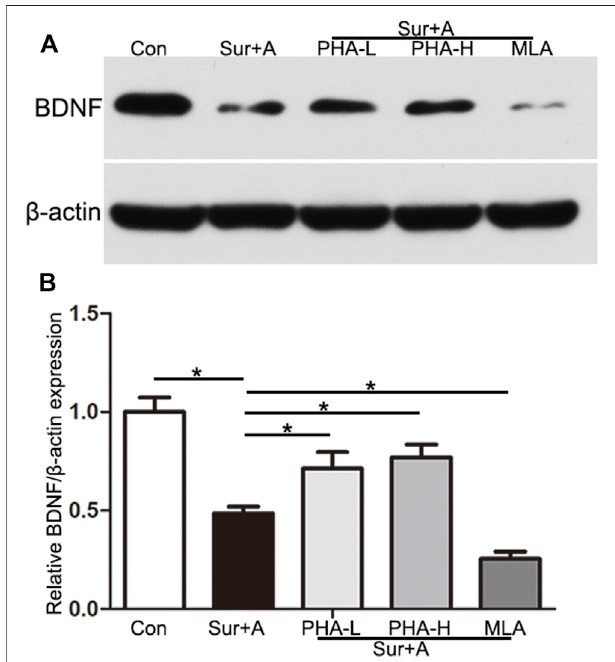
FIGURE 4 | α 7nAChR mediates BDNF expression in the hippocampus. (A) Representative Western blots of brain-derived neurotrophic factor (BDNF) in the hippocampus 2 h after surgery. β -actin was used as a loading control. (B) Quantitative analysis of BDNF levels. Data are presented as the mean ± SD. * p < 0.05. Con, Control; Sur+A, Surgery plus Anesthesia;PHA-L, low-dose PHA (0.3 mg/kg); PHA-H, high-dose PHA (0.6